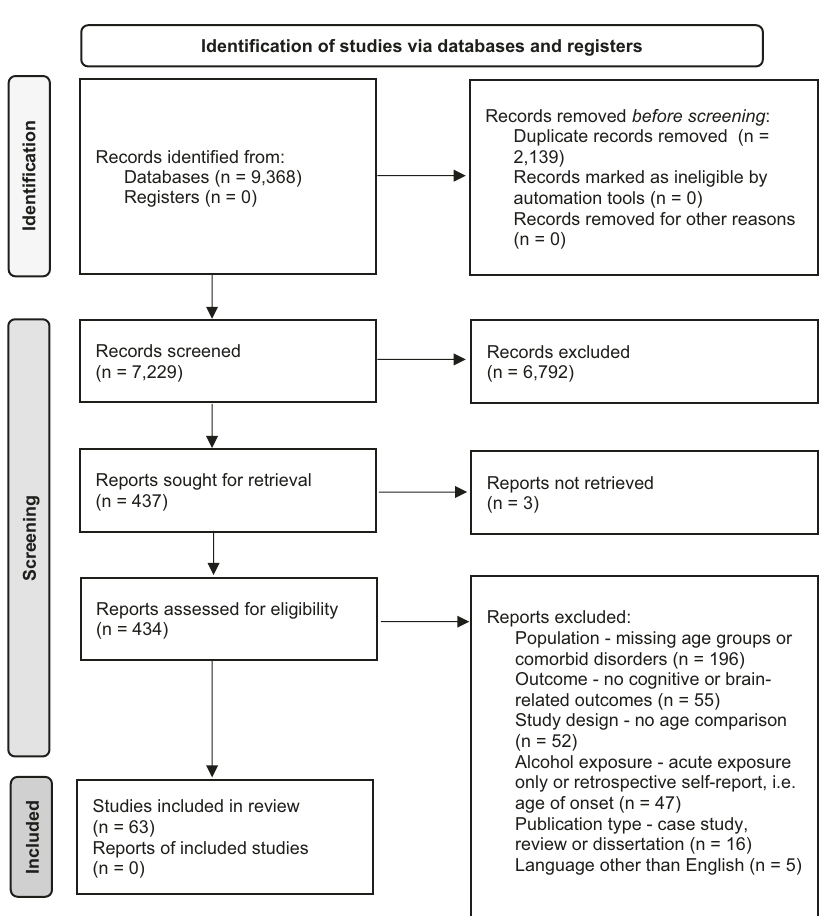
Fig. 2 PRIMSA fl ow diagram detailing the screening